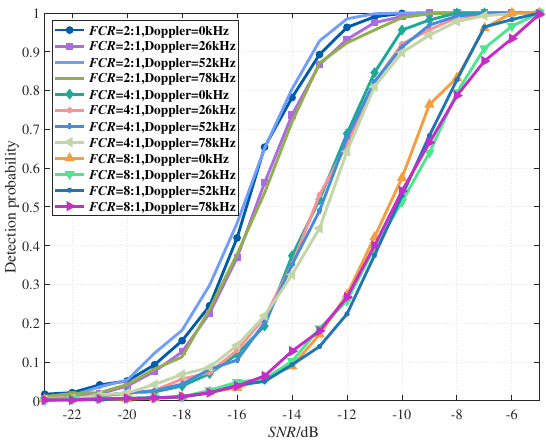
Figure 7. The detection probabilities with different Doppler frequencies.